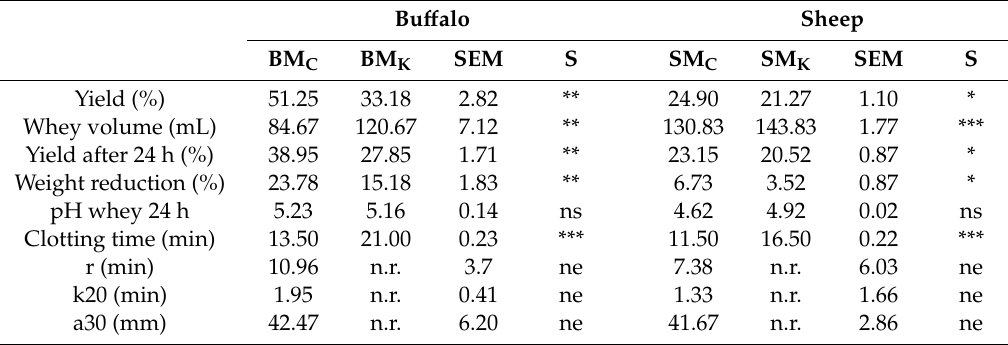
Table 1. Technological parameters of the cheeses made with kiwi extract or calf rennet. Bu ff